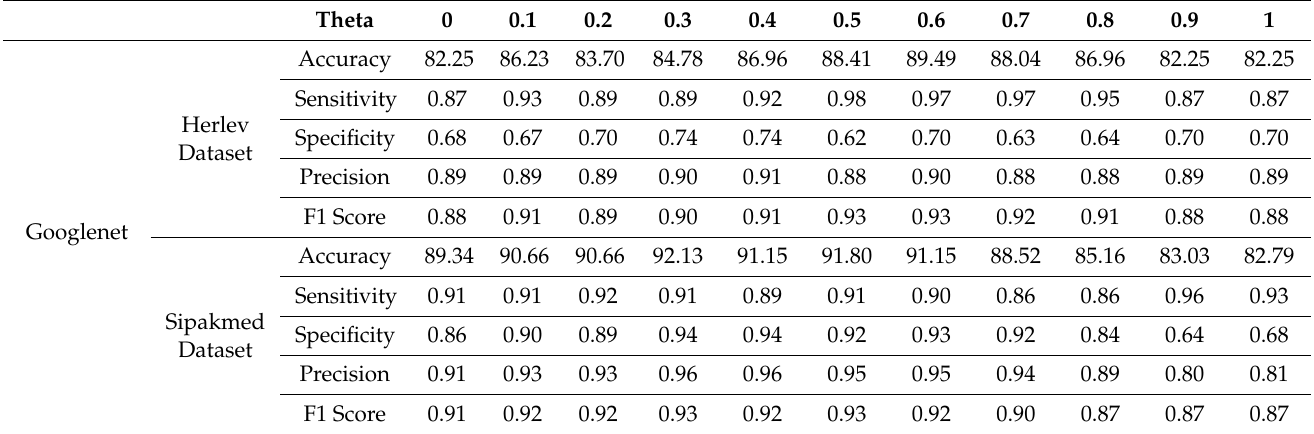
Performance Evaluation of Googlenet Pre-Trained Model with Fuzzy Min–Max Neural Network.